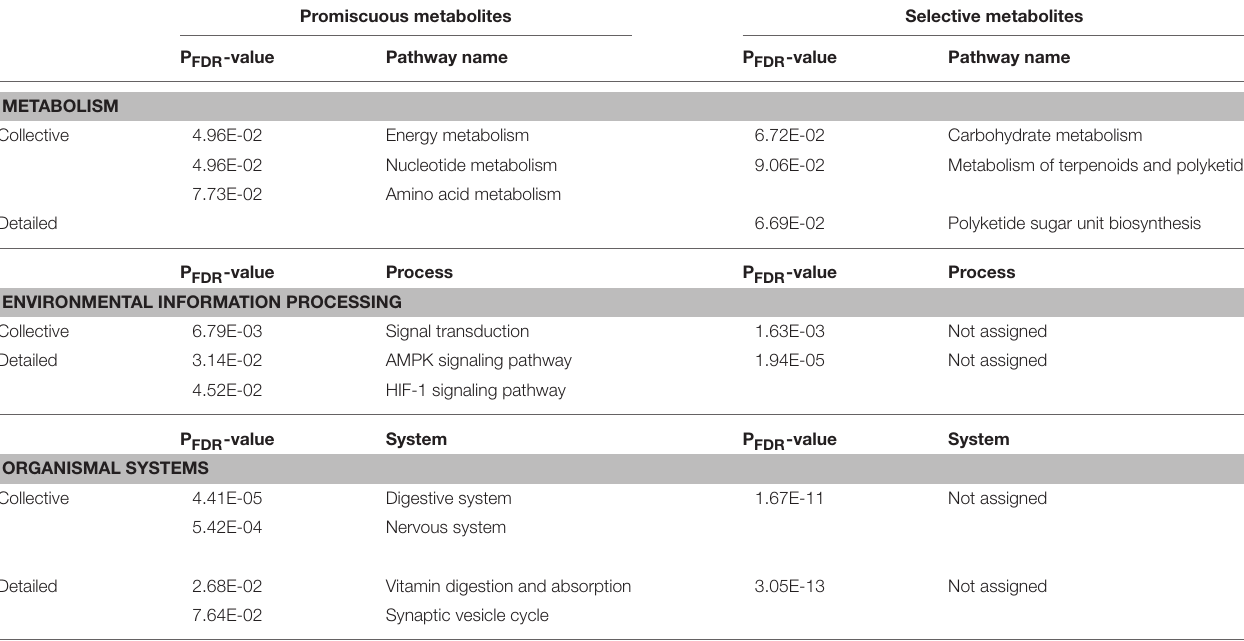
TABLE 4 | Metabolite pathway, process, organismal system ontology enrichment with respect to compound